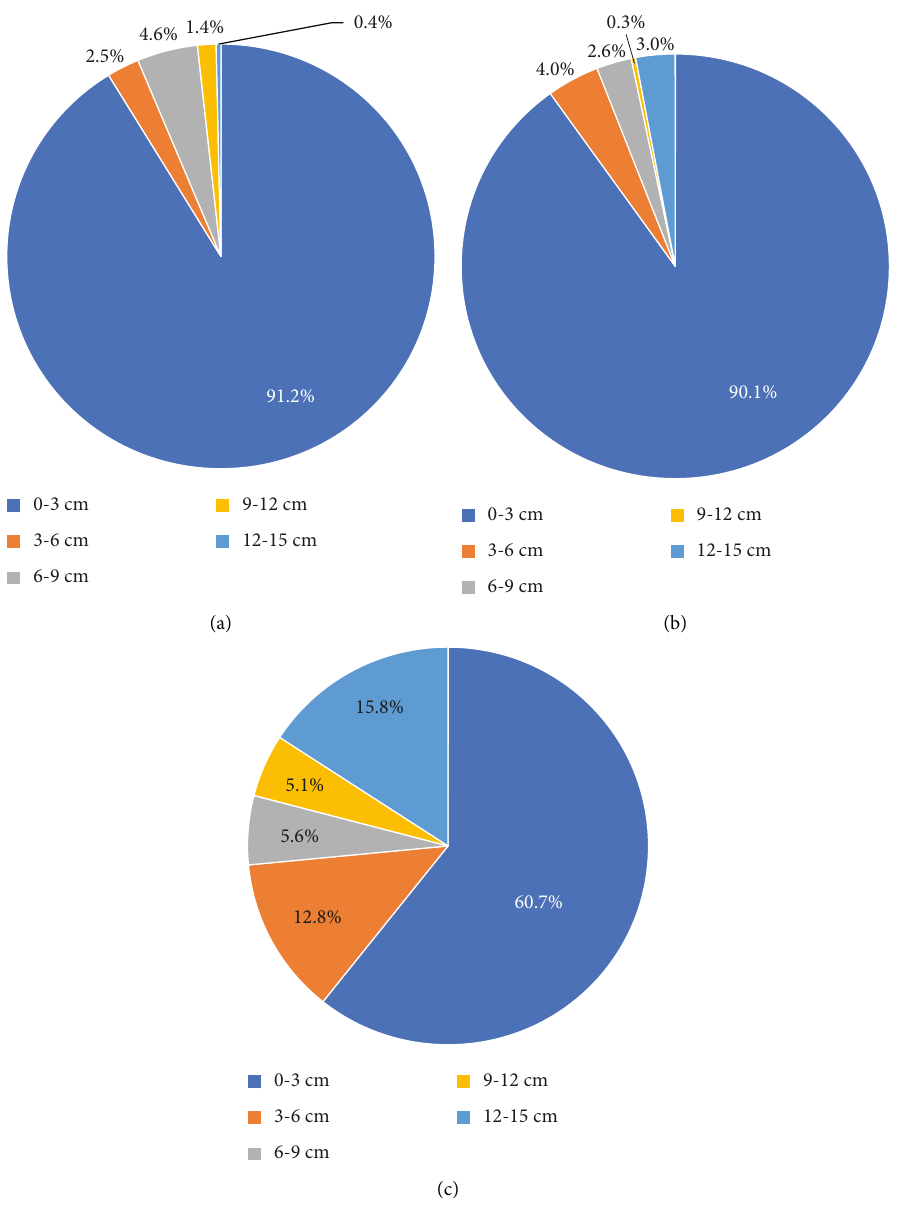
Figure 5: The block scale proportional distribution of different specimens. (a) One coal and one rock; (b) two coals and one rock; (c) one coal and two